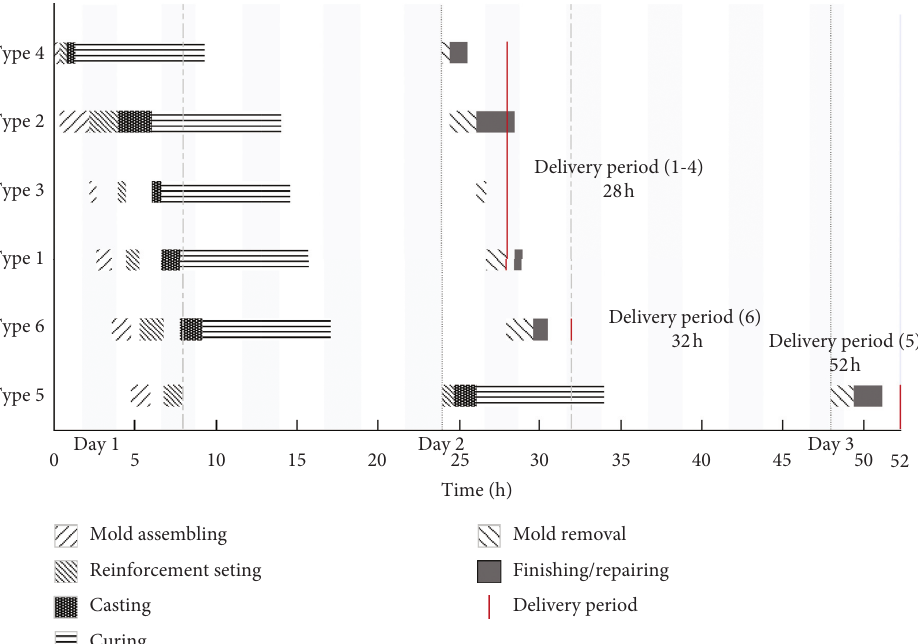
Figure 6: Gantt chart of completion time of each process based on